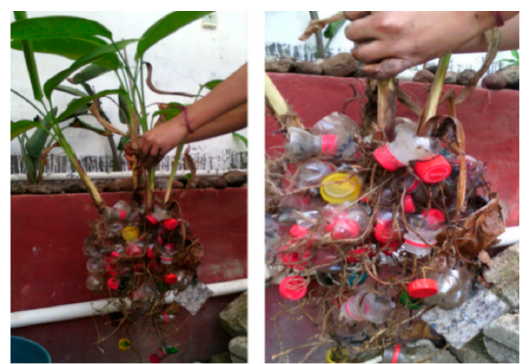
Figure 5. Radical development in PET substrate.